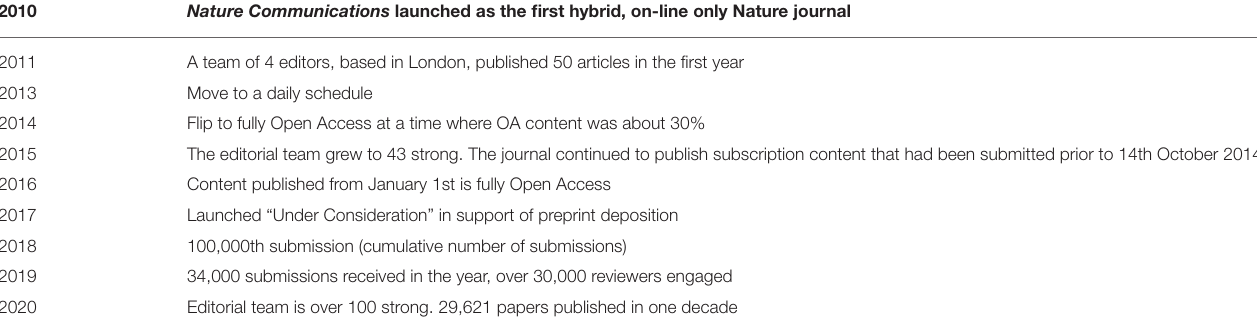
TABLE 1 | Nature Communications at 10 (2010–2020), adapted from Infographic: Nature Communications through the years.